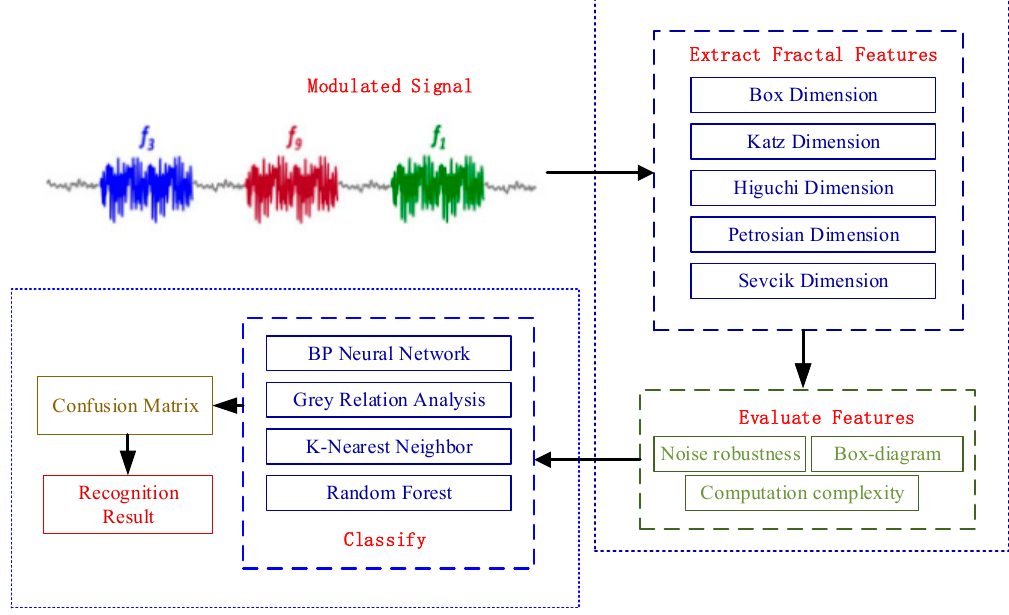
Figure 1. Signal pattern recognition process in this paper.